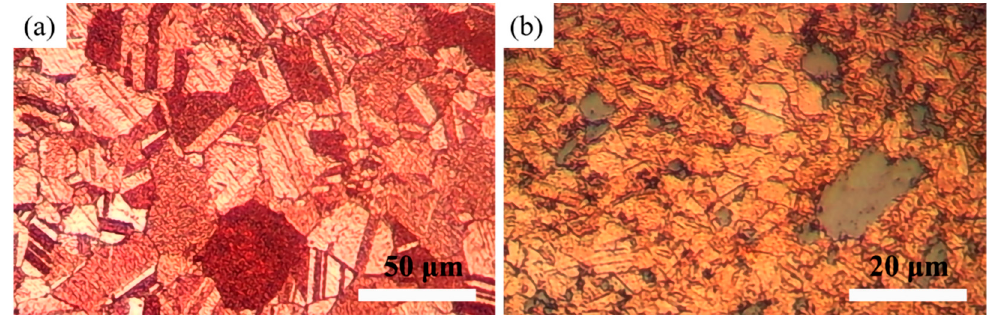
Figure 3. Optical microscope (OM) images of pure Cu ( a ) and Cu-5 vol.% V 2 C composite ( b ).